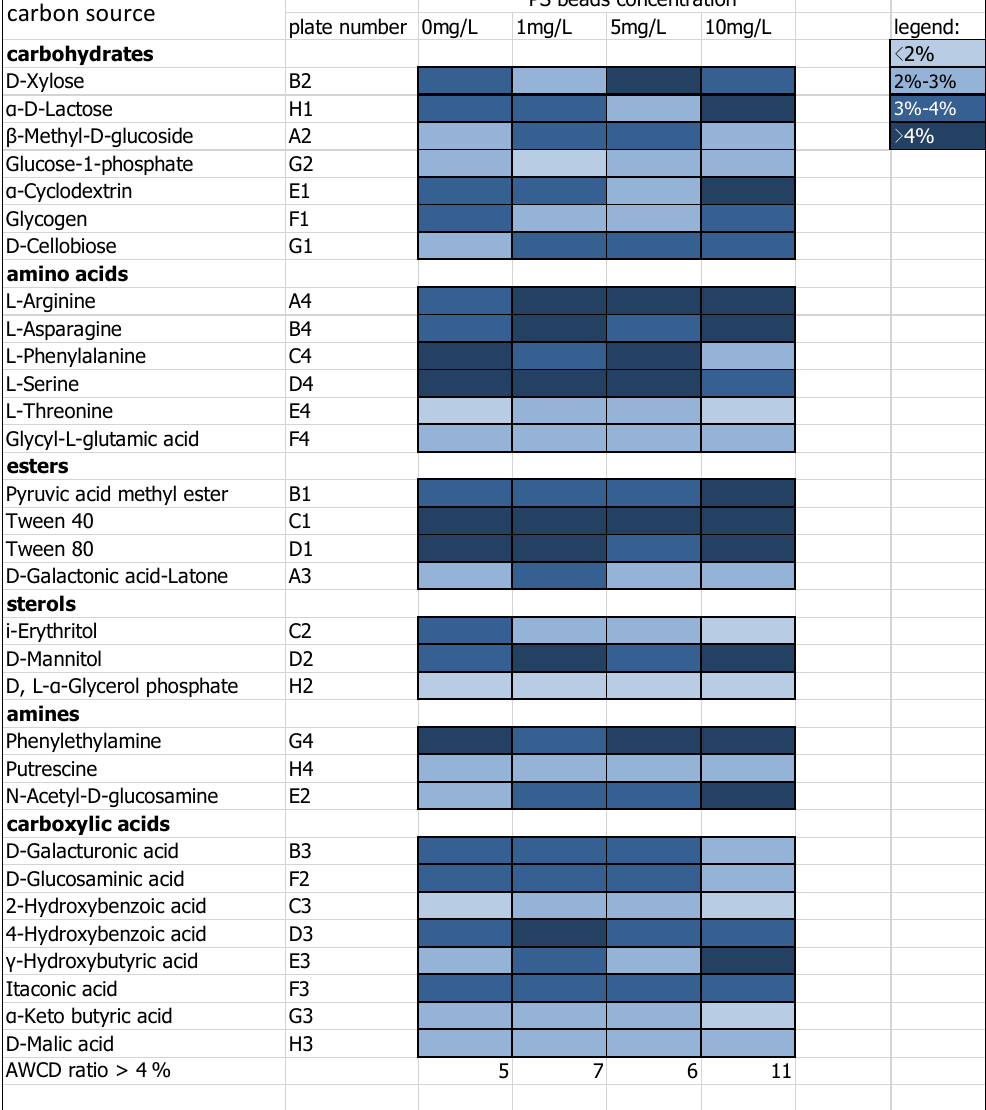
Figure 4. The carbon utilization pattern of 31 specific carbon sources by the freshwater biofilm microbial community exposed to an NP-introduced environment. Light blue indicates low carbon source usage by the microbial community and darker shades of blue indicate higher usage.